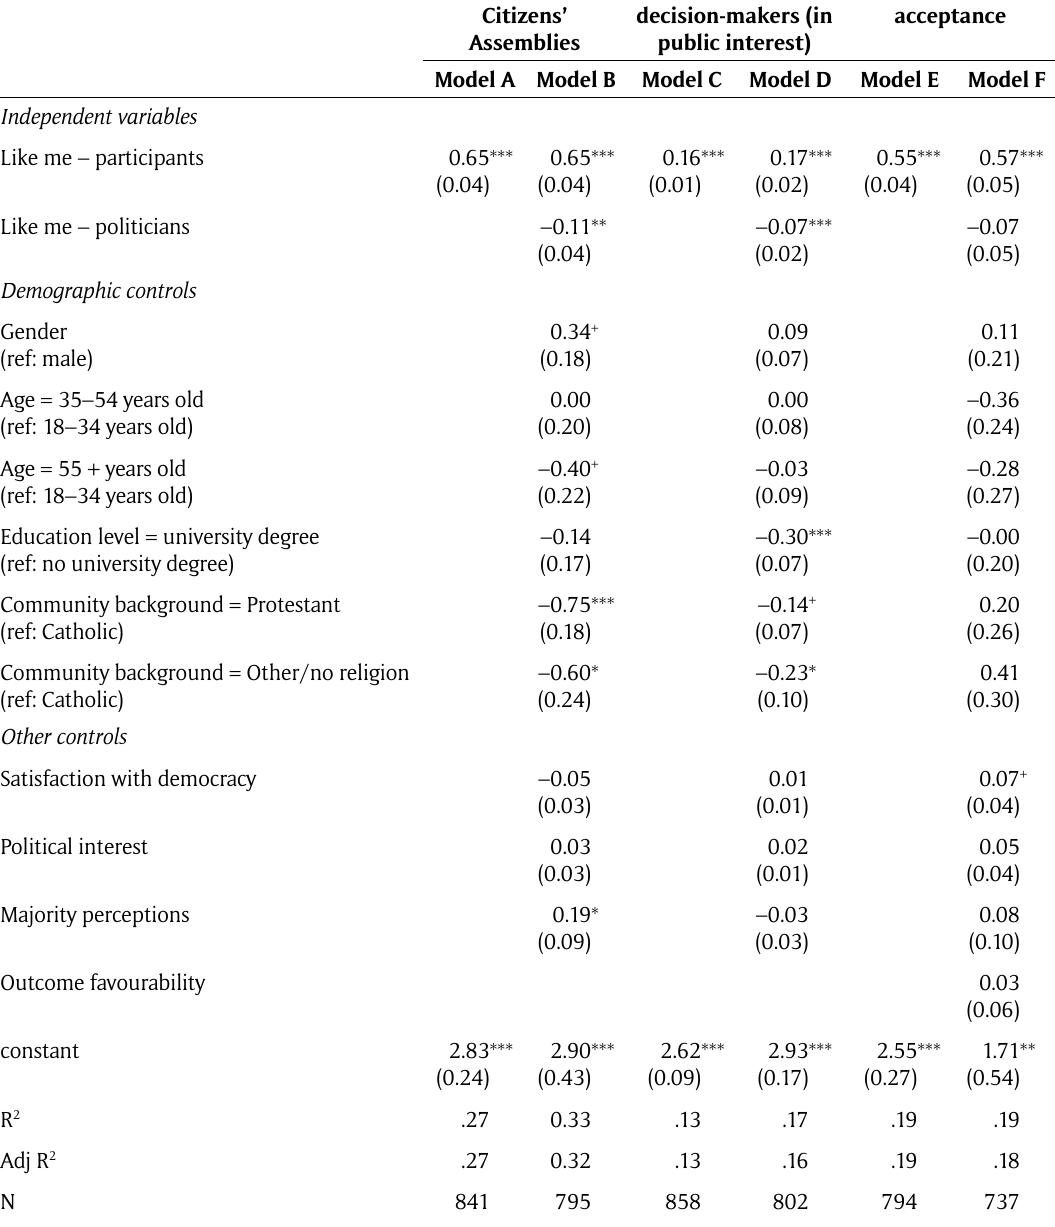
Table 1: Explaining legitimacy perceptions of